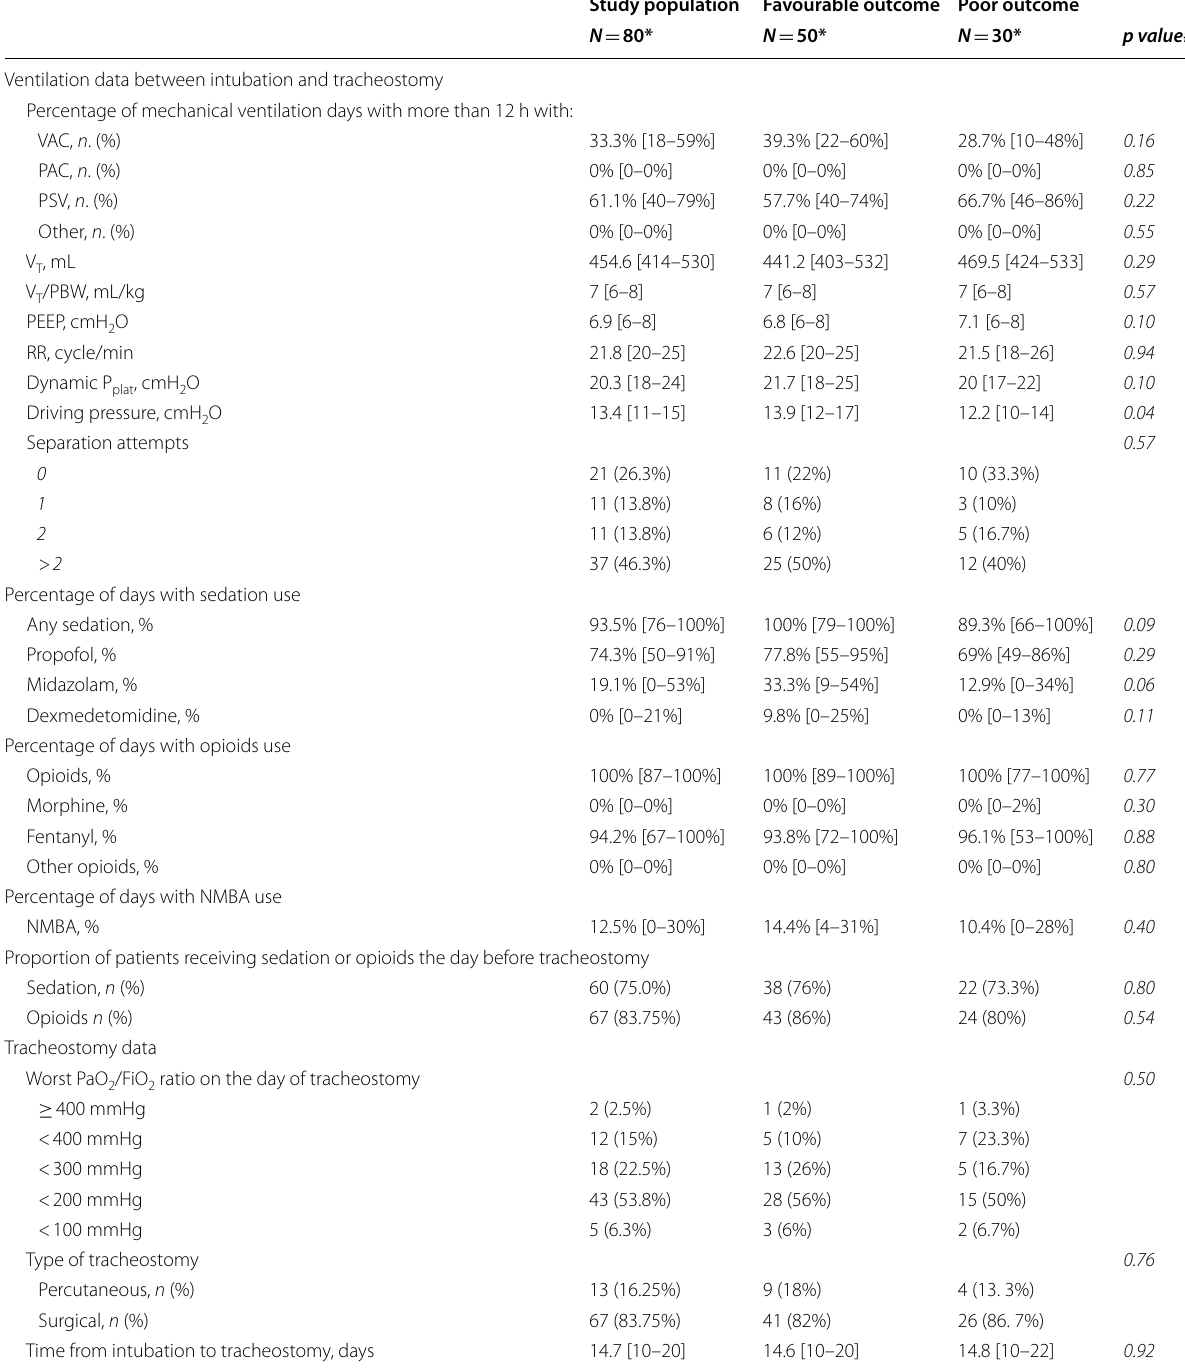
Table 3 Ventilation data, sedation, opioids, NMBA use and tracheostomy